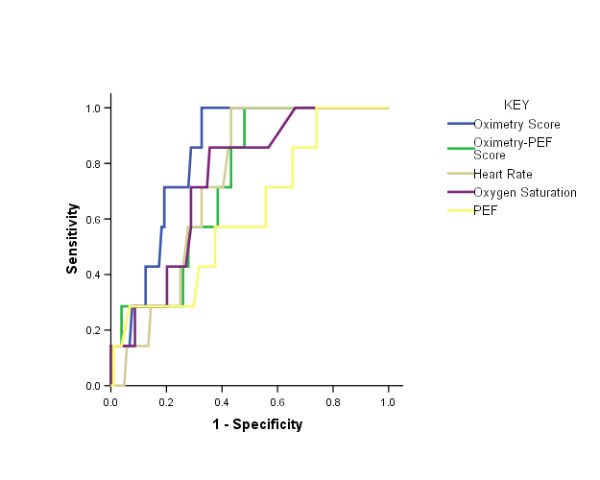
ROC Curves. ROC curves for the ability of the individual components, and Oximetry and Oximetry-PEF scores to differentiate exacerbation onset from day-to-day symptom variation (symptom days) in COPD. The data are reported in Table 4.